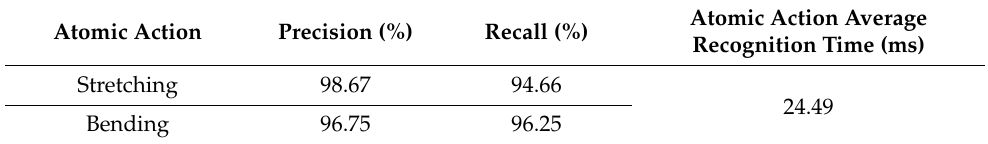
Table 2. Performance of single-shot detector (SSD) for validation data.